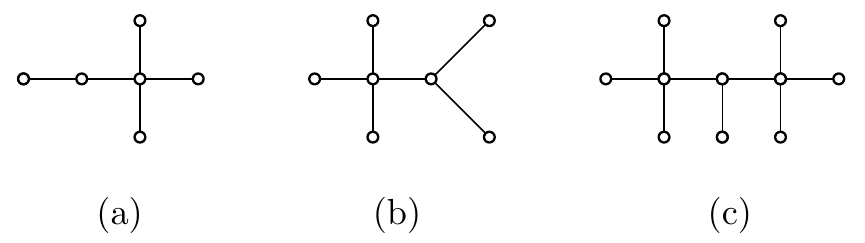
Figure 1: The trees with the minimum HA value among all molecular trees of order (a) n = 6 , (b) n = 7 , (c) n = 10 . (iii). the trees containing neither any vertex of degree 2 nor any vertex of degree 3 are the only trees with the minimum HA index and that minimum value is 19 n − 31 25